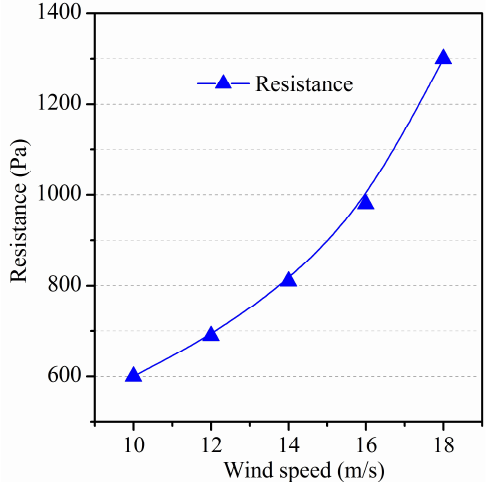
Figure 13. Relationship between wind speed and resistance.